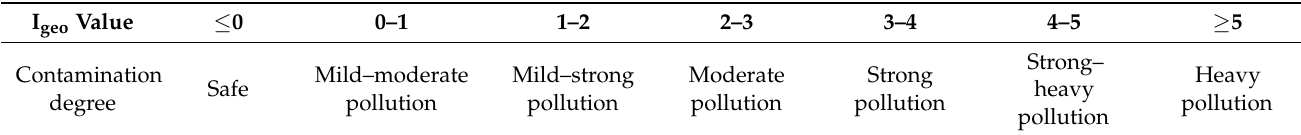
Table 1. Geoaccumulation index classification and pollution degree.